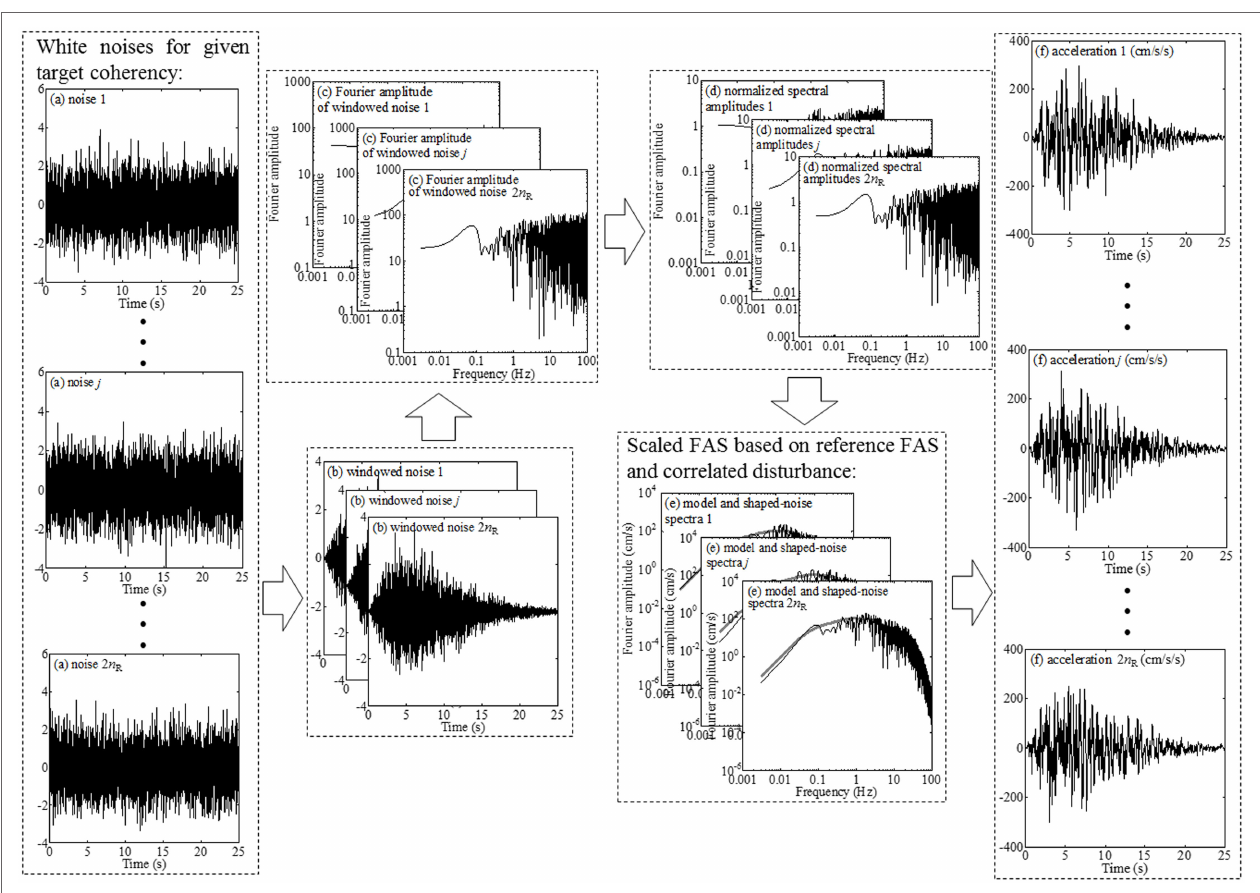
FIGURE 1 | Illustration of simulating spatially correlated and coherent record using the extended finite-fault model.